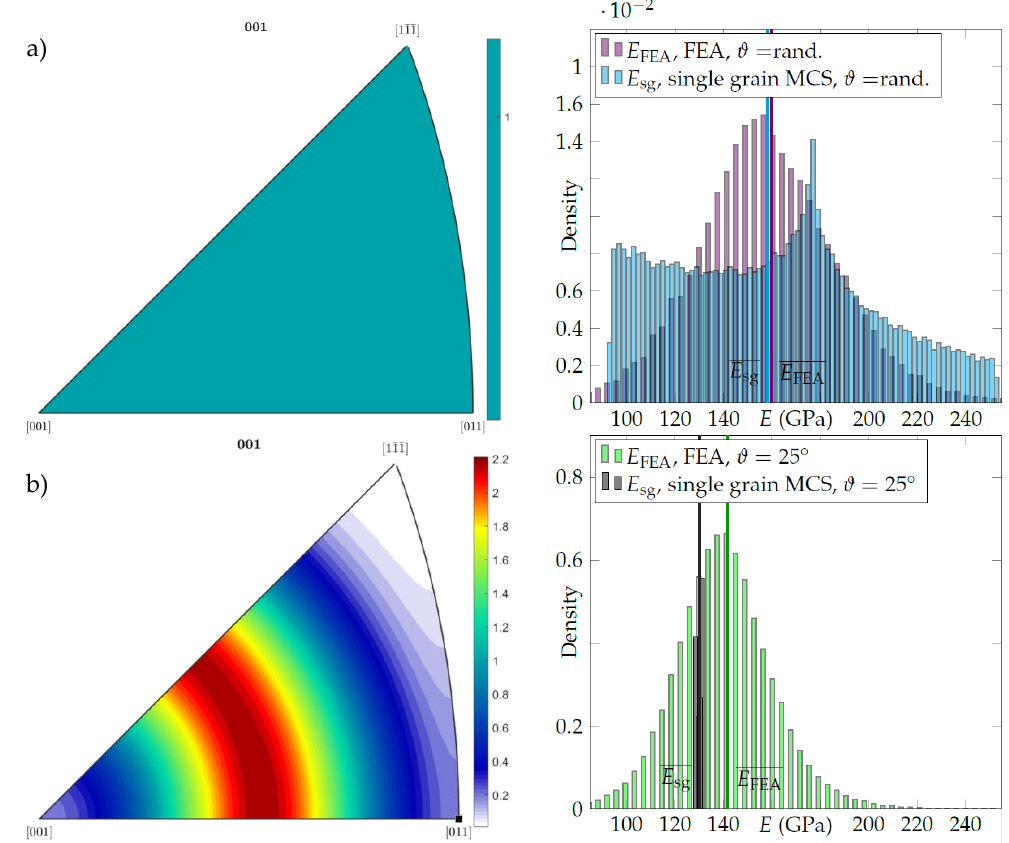
Figure 17. Orientation distribution functions and resulting local sti ff ness distributions (z-direction). ( a ) Isotropically distributed grain orientation: Resulting local stiffness distribution from a single crystal Monte-Carlo simulation ( 𝐸 𝑠𝑔 , cyan) and from polycrystalline FEA results ( 𝐸 𝐹𝐸𝐴 , violet). ( b ) Preferential grain orientations: Resulting local stiffness distribution from a single crystal Monte-Carlo simulation ( 𝐸 𝑠𝑔 , gray) and from polycrystalline FEA results ( 𝐸 𝐹𝐸𝐴 , green). The global Young’s mod uli averaged from nodal FEA stresses (z-components only) have a difference of 18 GPa between the batch with (coarse) and without preferential grain orientation (fine). The ratio 𝐸 𝑐𝑜𝑎𝑟𝑠𝑒 /𝐸 𝑓𝑖𝑛𝑒 = 1.13 of the Young’s moduli averaged from FEA results is slightly larger for the experimental results where 𝐸 𝑐𝑜𝑎𝑟𝑠𝑒 /𝐸 𝑓𝑖𝑛𝑒 = 1.11 . Although also the absolute values of the tested Young’s moduli are slightly lower than the averaged computed values t he comparison of the ratios indicates a good qualitative consistency. That is a satisfying outcome as it confirms the applicability of the elasticity model from IN 738 LC for René80 with respect to the anisotropies at 850 °C. Nevertheless, the uncertainties in the determination of the Young’s moduli must not be neglected. orientation realizations at one grain morphology. The simulated grain orientation distributions are